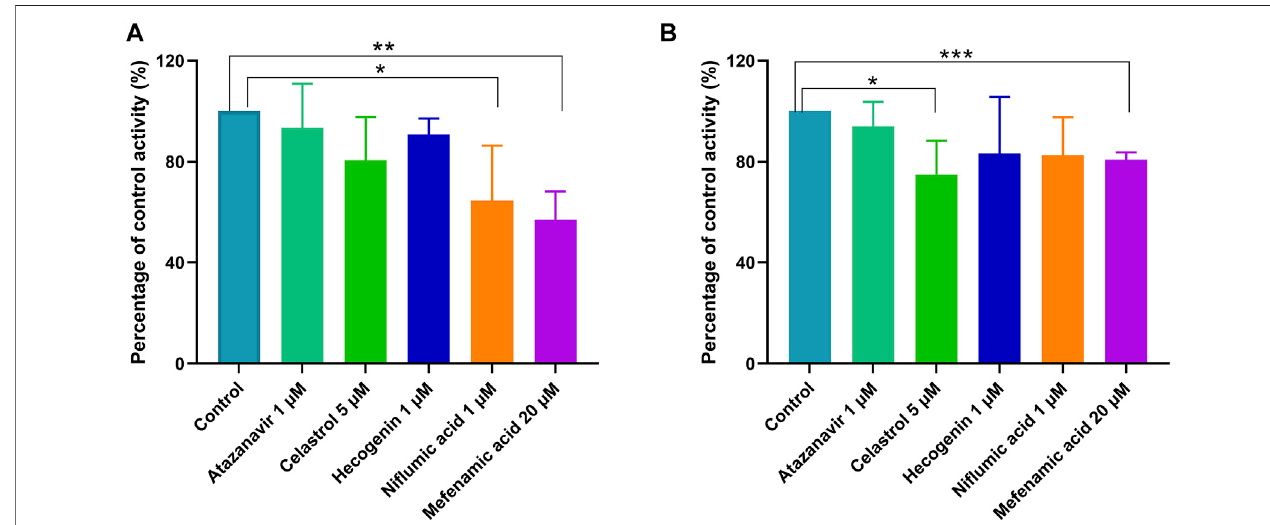
FIGURE 5 | Inhibitory effects of typical UGT inhibitors on ticagrelor glucuronidation in pooled HLM (A) and HIM (B) . Data represent the mean ± S.D. of triple incubations.